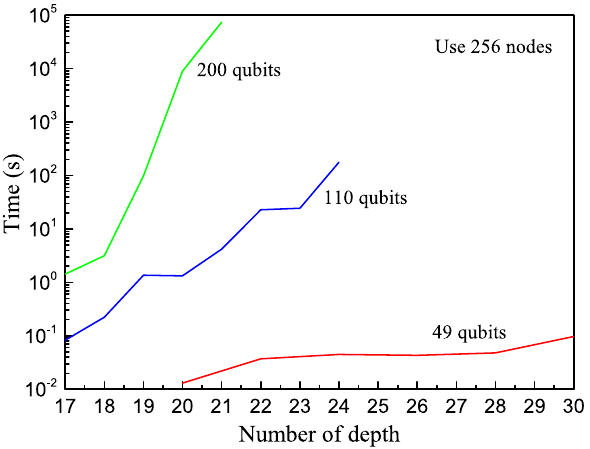
Figure 6. The time span of executing random quantum circuits on the single amplitude mode. The circuit with 200 qubits and 21 depths was simulated.